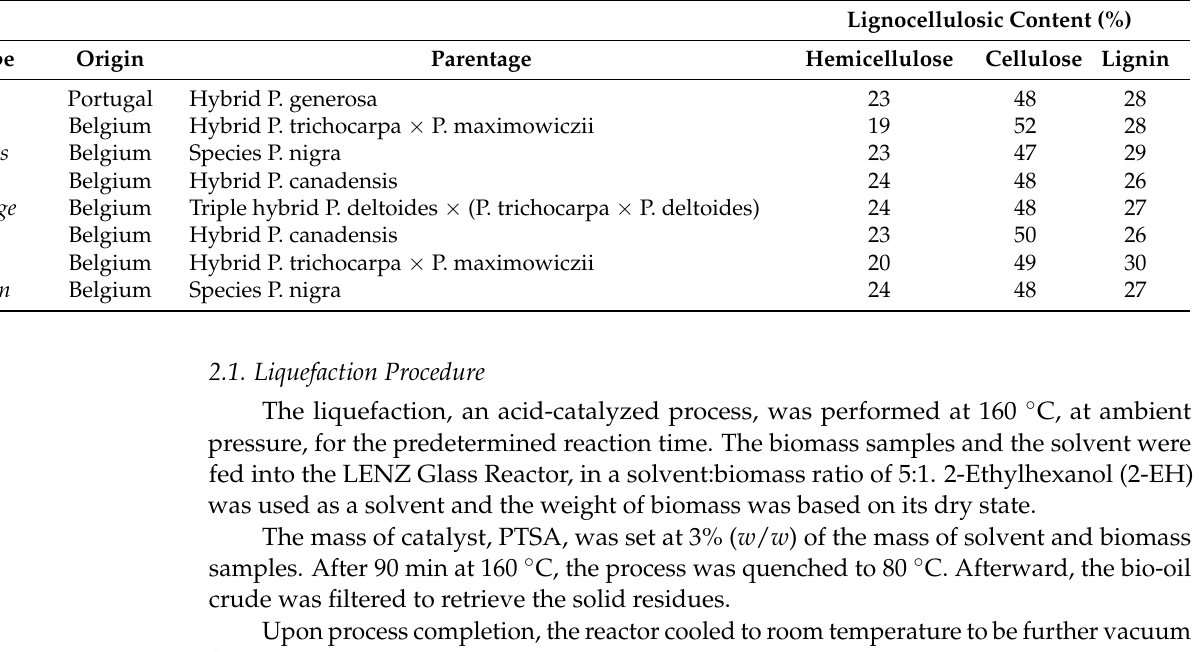
Table 1. Hemicellulose, cellulose, and lignin estimated the content of the poplar genotypes [48].